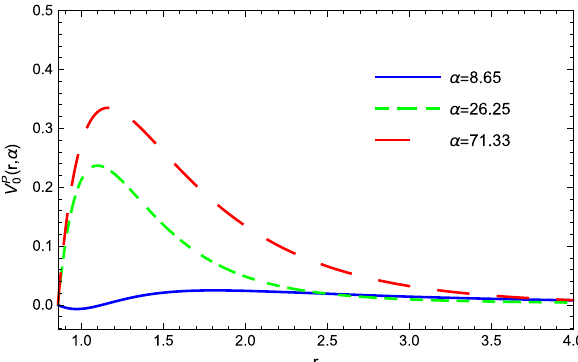
( r ,α) for l = 0 mode around Fig. 9 Three scalar potential graphs V P 0 the n = 0 (α ≥ 8 . 019 ) black hole. The whole potentials are positive definite except that the α = 8 . 65 case having negative region near the horizon does not imply instability